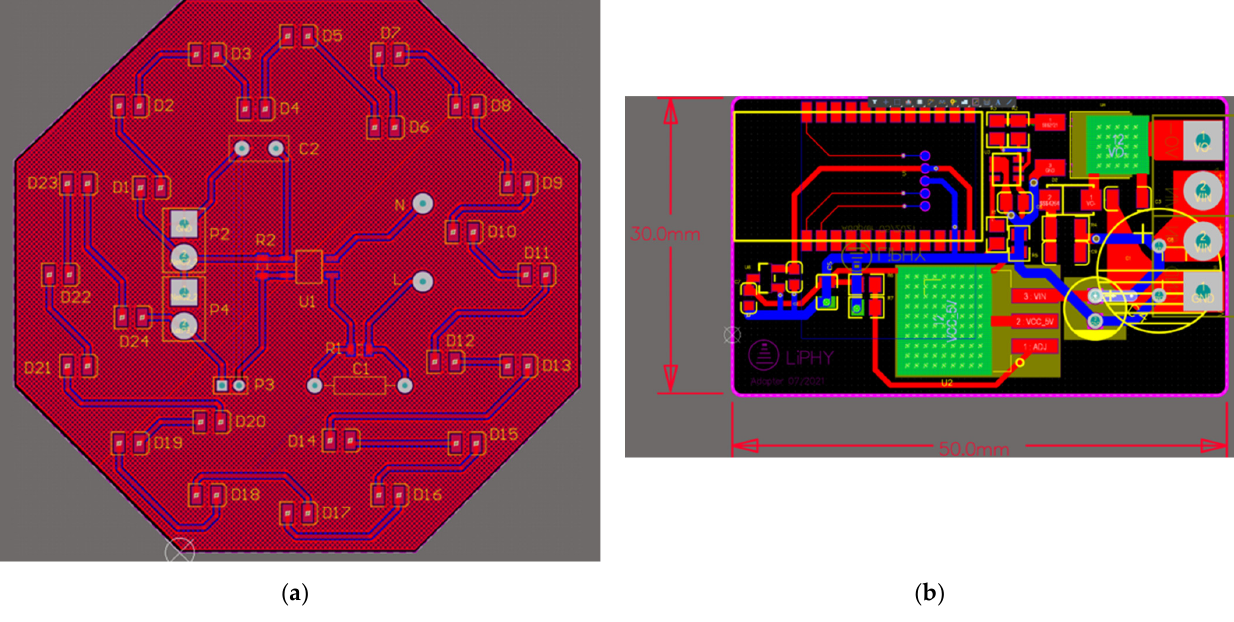
Figure 6. Details of PCB for the designed VLC LED lightbulb: ( a ) layout of LED and power manage- ment board; ( b ) layout of BLE control board.